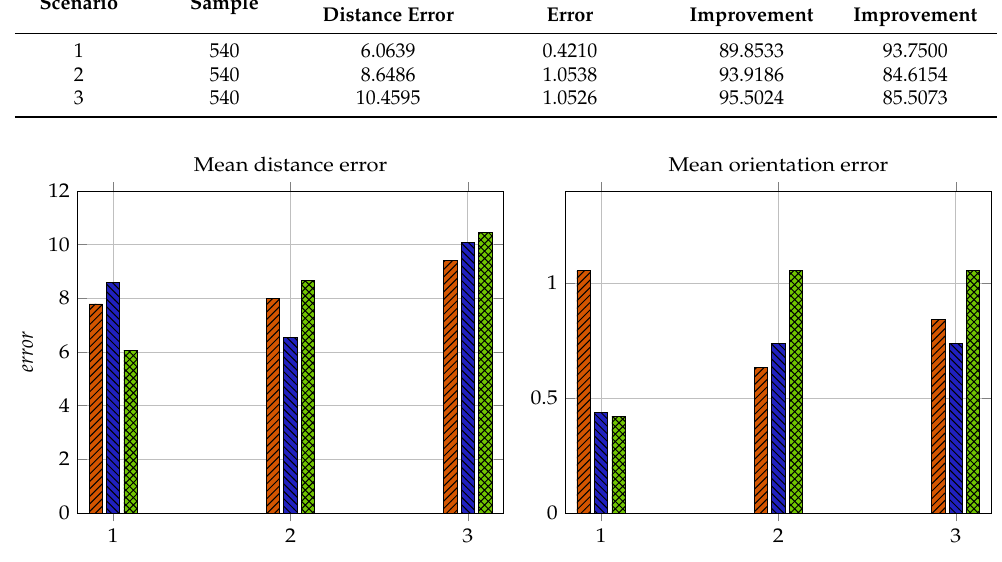
Figure 8. Mean distance and orientation error in different scenarios.